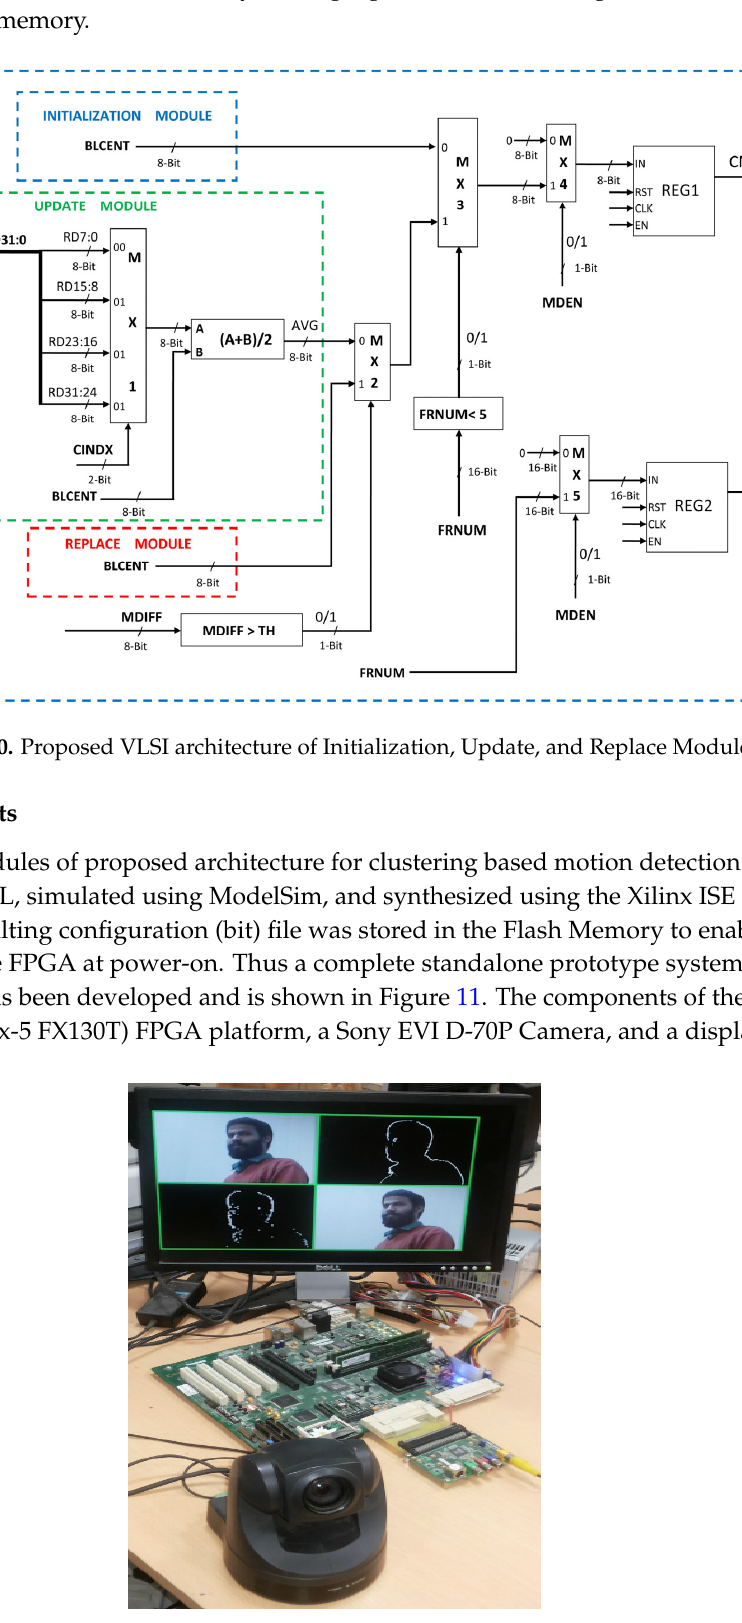
Figure 11. Complete Motion Detection System Setup.